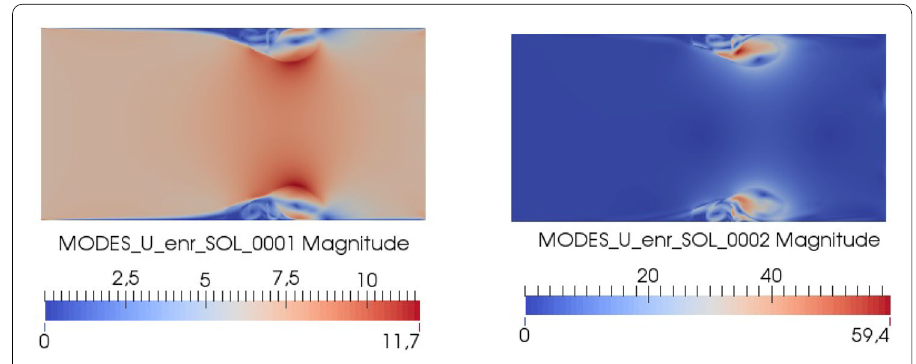
Fig. 4 On the left, (cid:3) E the first POD mode with the set of all snapshots with the two configurations. On the 1 the second POD mode with this set right, (cid:3) E 2